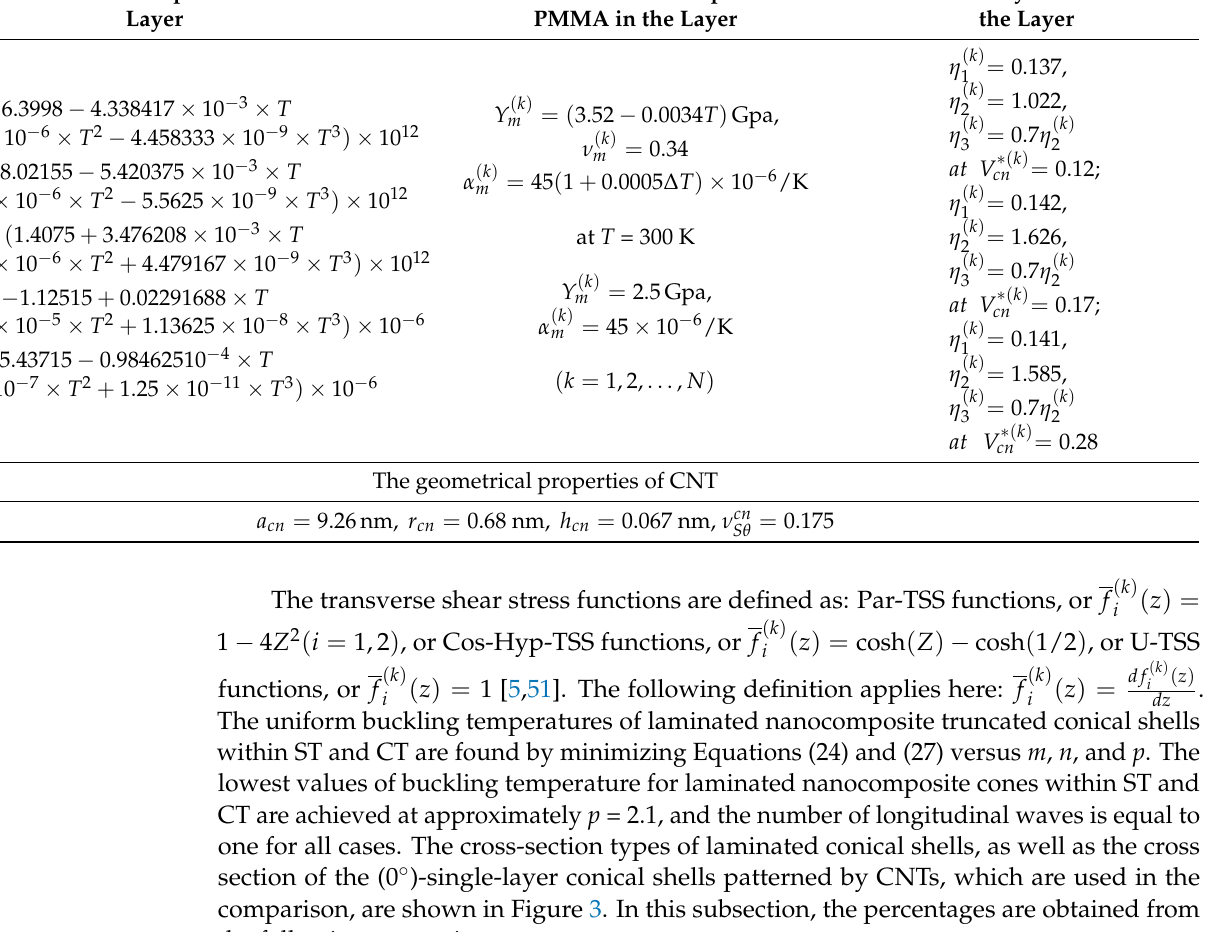
Thermo-Mechanical Properties of CNTin